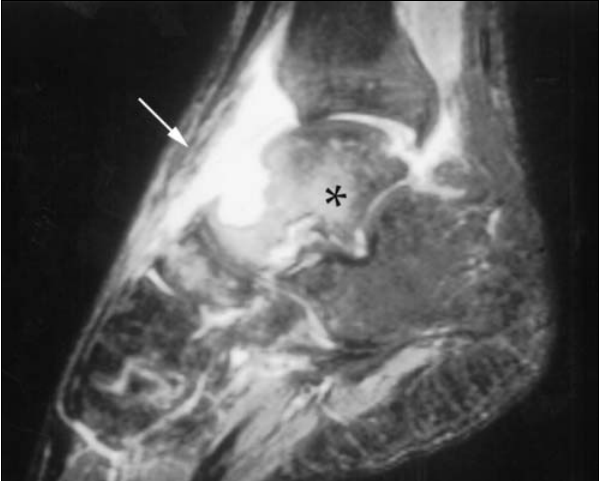
Figure 2) Sagittal T2-weighted magnetic resonance imaging of the left ankle showing high signal intensity compatible with septic arthritis and osteomyelitis of the talus (asterisk), with a sinus tract draining to the skin (arrow)